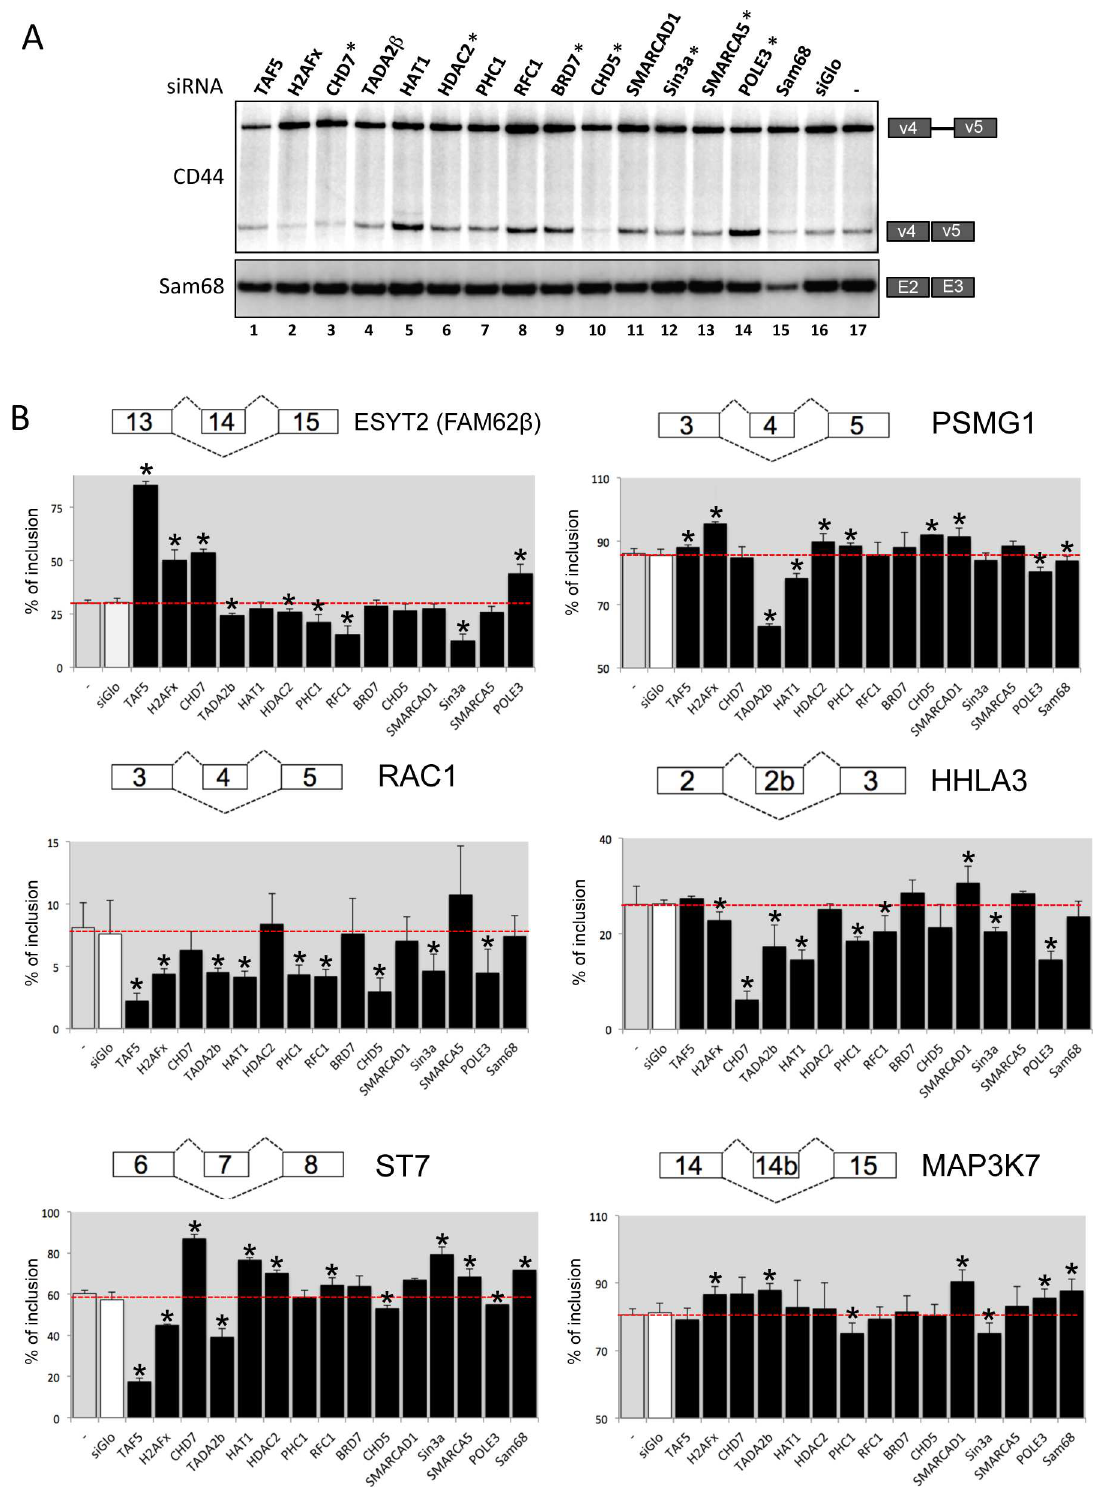
Fig 3. Chromatin factorsaffectthe regulationof endogenous splicing. SiRNAs targeting14 chromatinfactors and identifiedas affecting splicing of v4-v5-ren in 293-ECRcells were transfected into HeLa cells as well as siRNA targeting controls.(A) RadiolabeledRT-PCR was then used to examine splicing of exons v4-v5 fromendogenous CD44 and exons 2 and 3 fromSam68.The chromatinfactors identifiedby mass spectrometry are highlightedwith asterisks.(B)